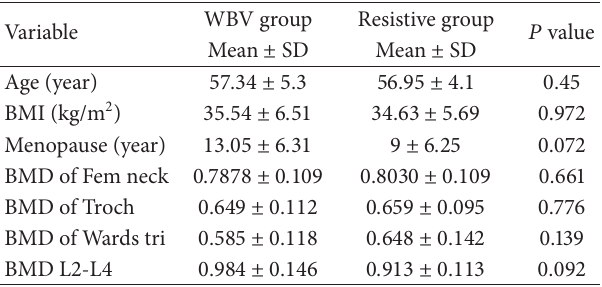
Table 1: Baseline characteristics of participants for the WBV and resistive exercise